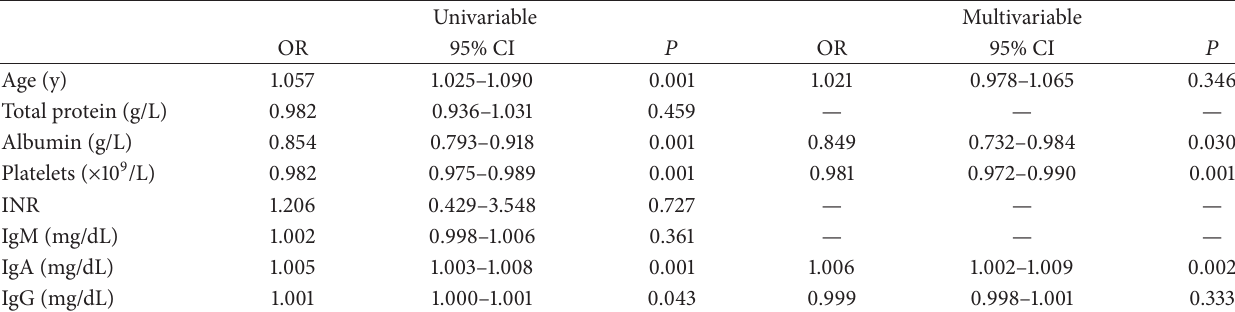
Table 3: Uni- and multivariate analysis of factors associated with hepatic cirrhosis. Univariable